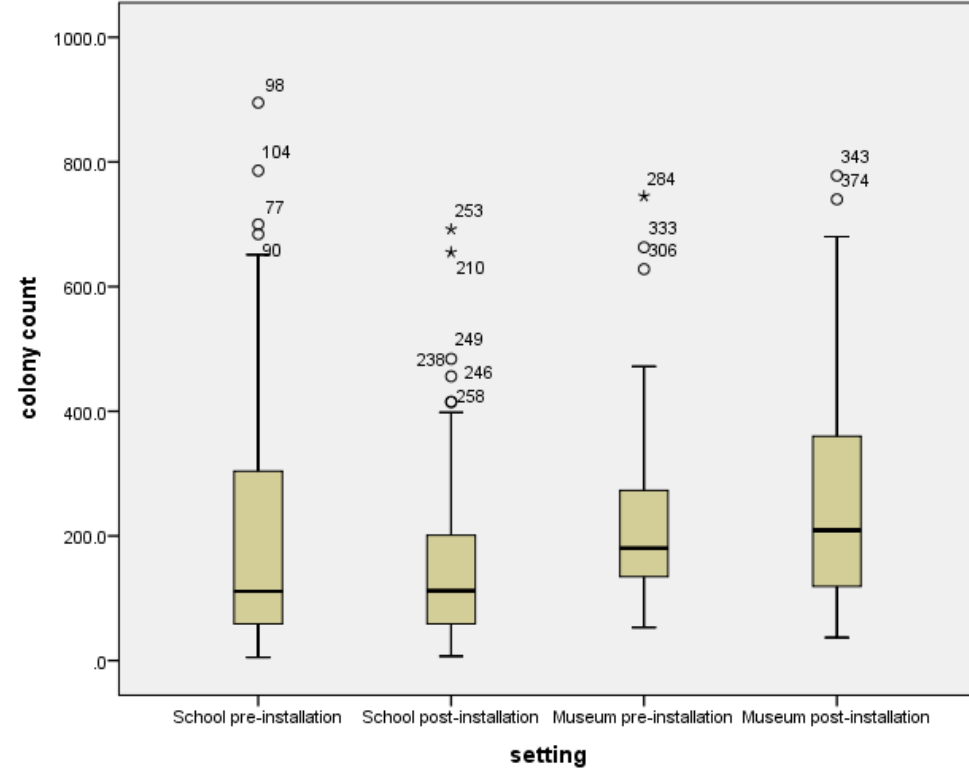
Figure 4. School 1 and museum agar plate results.